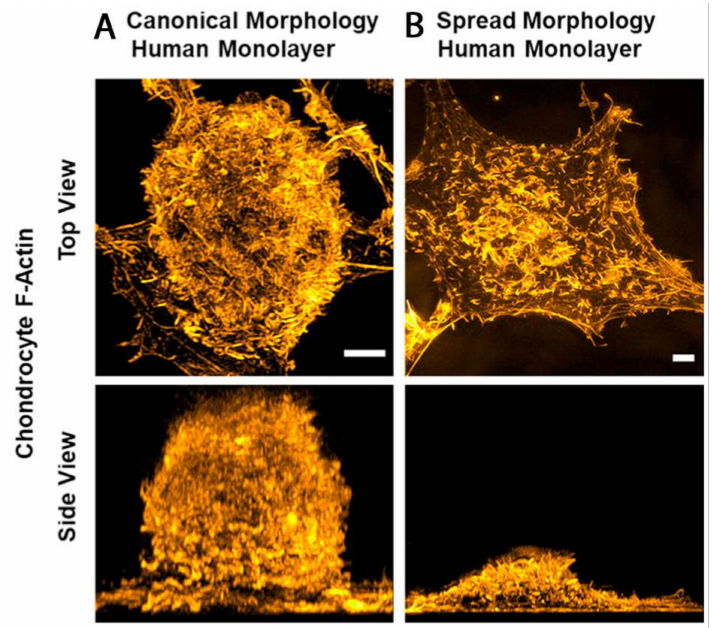
Figure 4. ( A ) Rounded vs. ( B ) spread morphologies of primary hCHs imaged in super-resolution using 3D structured illumination microscopy (3D-SIM) on a GE DeltaScan OMX SR